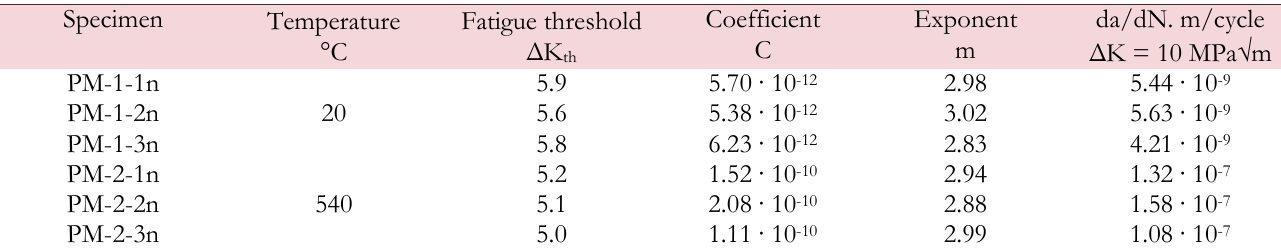
Table 5: Fatigue crack growth parameters for specimens with notches in new PM.